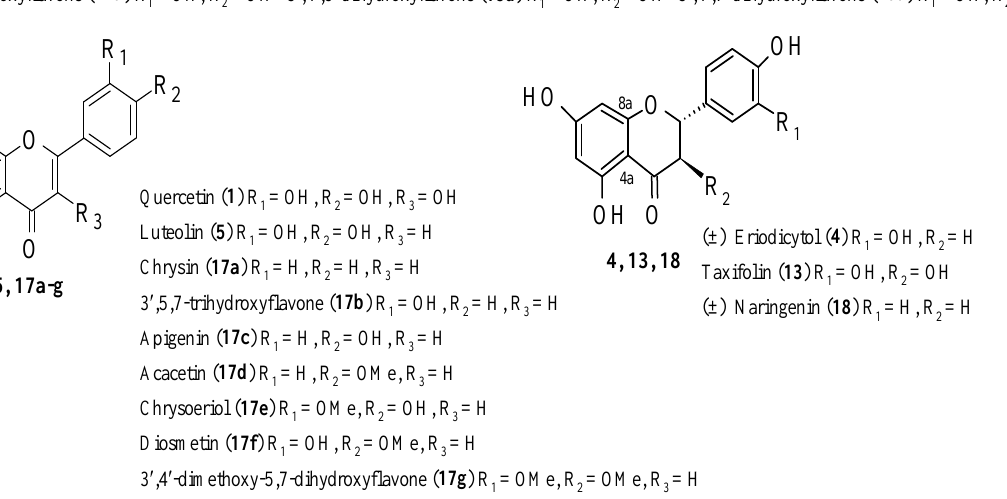
Figure 3. The chemical structures of studied flavonoids in inhibiting the formation of LTB4 [27]. Additionally, using linoleic acid as a substrate, Sadik et al. studied the anti-inflammatory effects of 18 flavonoids on rabbit reticulocytes and soybean 15-LOX [28]. Firstly, it was discovered that the phenolic hydroxyl groups were not required for the inhibition. The hydroxyl group at C3 was found to be non-essential for inhibition, as evidenced by the luteolin’s ( 5 ) greater effectiveness than the quercetin ( 1 ). Apart from that, the presence of catechol moiety in the A-ring or B-ring can increase the inhibitory action. Following that, sugar moiety can significantly reduce the inhibition as it can decrease flavonoids’ hydrophobicity, which leads to a decrease in affinity towards LOX’s active site. The